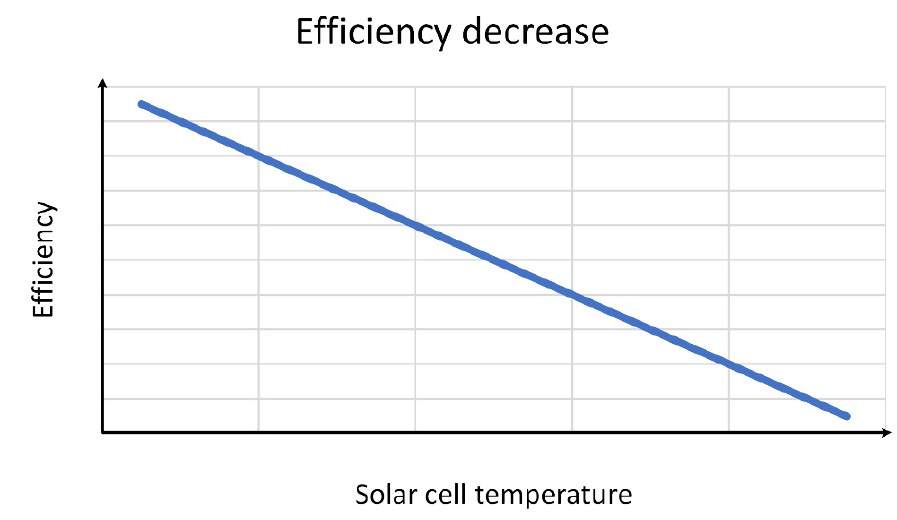
Figure 3. Efficiency decrease in solar